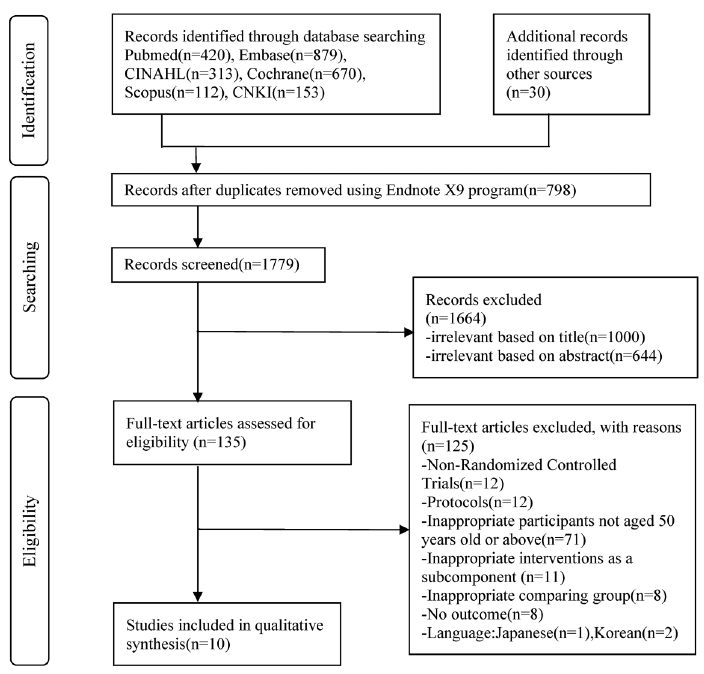
Figure 1. PRISMA fl ow diagram.